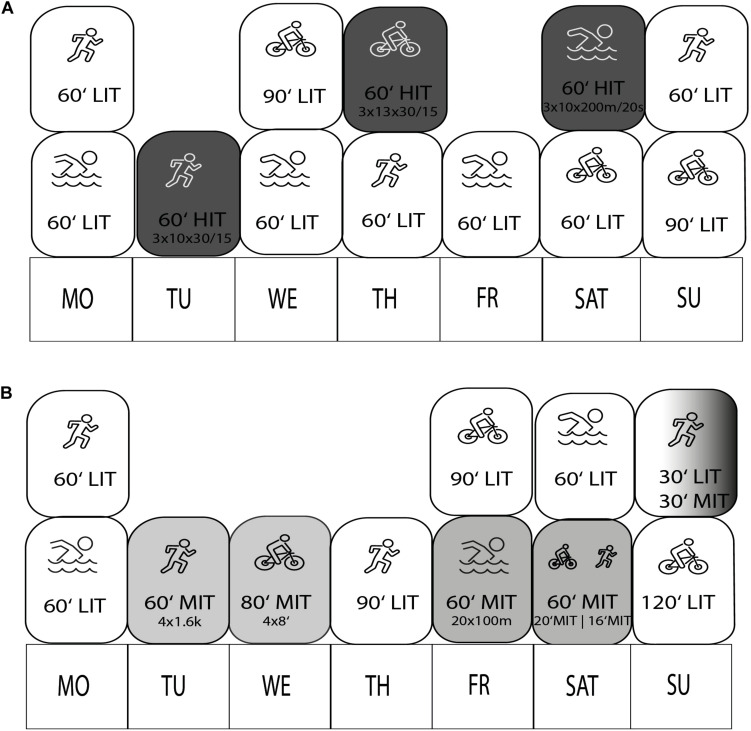
Weekly training schedule of INT (A) and CON (B) during the 6 weeks study period. LIT, low intensity training; MIT, medium intensity training; HIT, high intensity training.